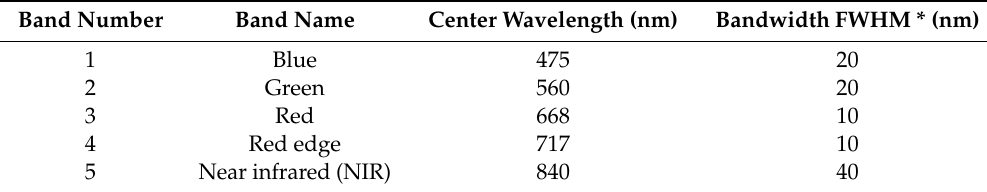
Table 1. Spectral resolution of the MicaSense RedEdge-M camera used in the study. Band Number Band Name Center Wavelength (nm)